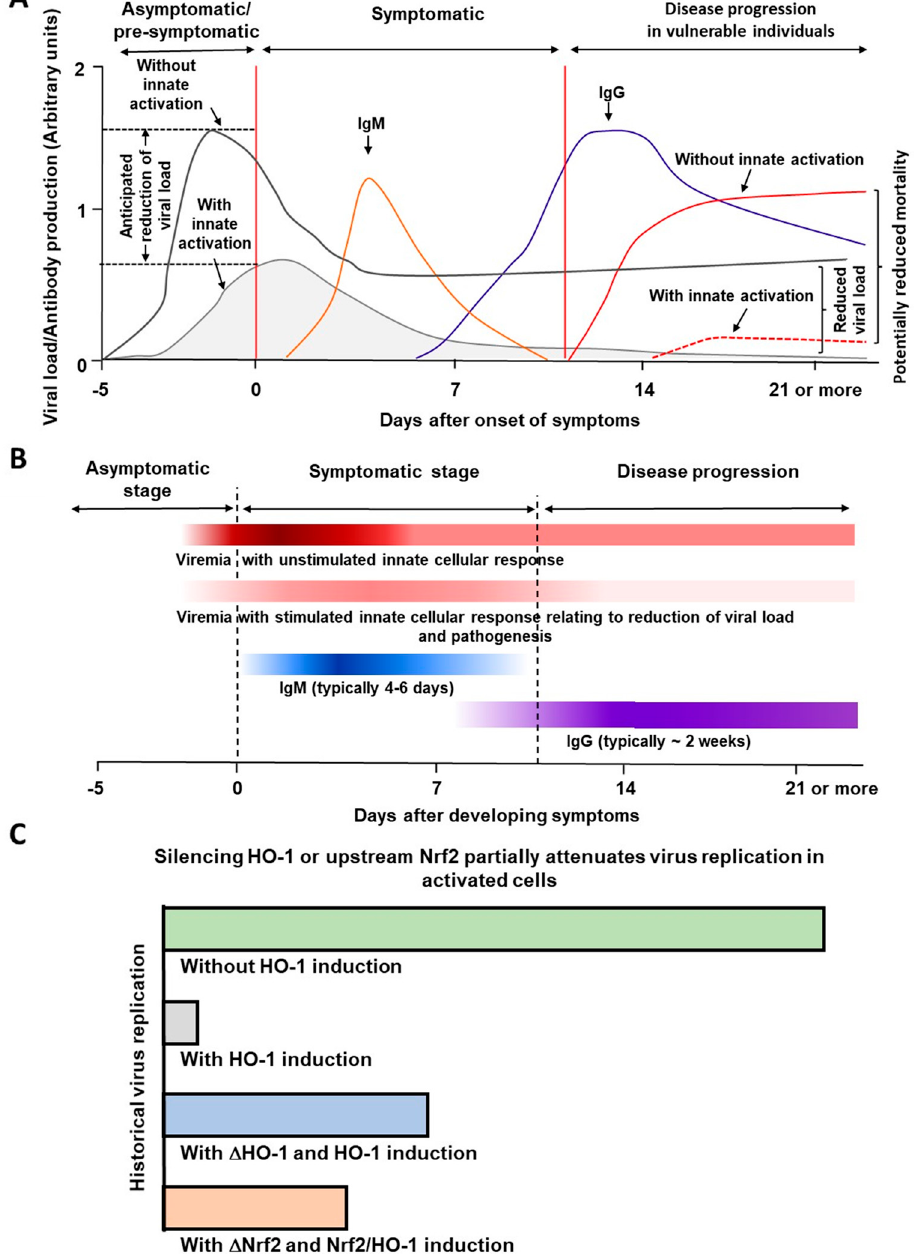
Figure 3. ( A ) A model depicting the importance of inducible innate cellular protective response against SARS-CoV-2 infection. ( B ) This model presents the concept of the stimulated innate immunity for reducing the viral load, retarding disease progression, and generation of the secondary humoral immune response. ( C ) A diagram illustrating the involvement of HO-1 and its upstream gene Nrf2 in reducing virus replication based on historical published data [8,9,12,17]. Panel A and Panel B are reproduced with permission from Refs. [28,29] Copyright 2021 Current Trends in Immunology.